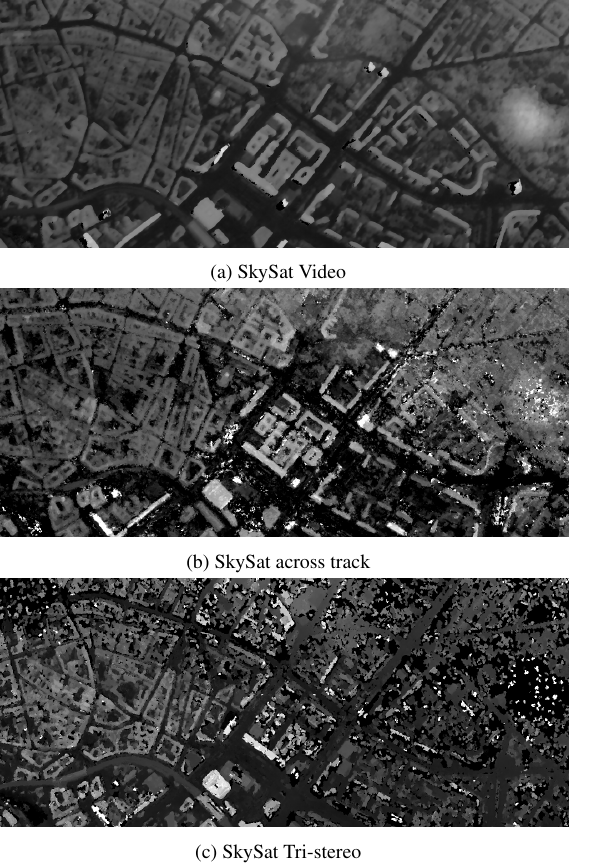
Figure 6. DSMs of Berlin, generated from different SkySat acquisitions contain buildings, but shows the topography much clearer than lower resolution DSMs, such as the 30m SRTM-C Band data